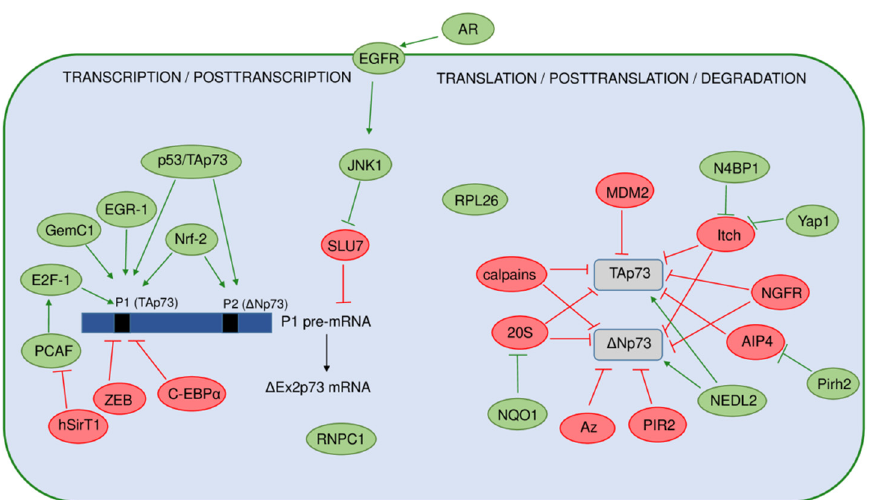
Figure 4. A model representing regulation of the p73 isoforms’ expression and stability. The positive regulators are shown in green, and the negative regulators are shown in red. On the transcriptional level, expression of the p73 isoforms is regulated by usage of two different promoters (P1 and P2) producing the TAp73 or Δ Np73 isoforms. Black bars represent the TP73 gene promoters. Several regulators specifically activate the P1 promoter, with transcription factor E2F-1 being the most important. In contrast, transcription from P1 is repressed by ZEB, C-EBP α , and hSirT1. The full-length p53 and the TAp73 proteins, as well as Nrf-2, have been found to induce both promoters. On the posttranscriptional level, the alternative splicing of P1 pre-mRNA, leading to increased expression of the Δ Ex2p73 isoform, is induced by the activation of EGFR by its ligand amphiregulin (AR) in hepatocellular carcinoma cells. The expression of the Δ Ex2p73 isoform is enabled by the inhibition of the RNA splicing factor SLU7 through JNK1 signaling. The stability of the p73 mRNA is increased by the RNA-binding protein RNPC1. Ribosomal protein RPL26 has been found to regulate the p73 translation and protein stability. The p73 protein isoforms are also extensively regulated on a posttranslational level. Here are shown different regulators of the TAp73 and Δ Np73 isoforms’ stability and degradation. Some of them target both TAp73 and Δ Np73 isoforms including Itch, NGFR, calpains, and NQO1 (through 20S proteasome). On the contrary, antizyme (Az) pathway and ligase PIR2 specifically target the Δ Np73 isoforms for degradation after DNA damage.